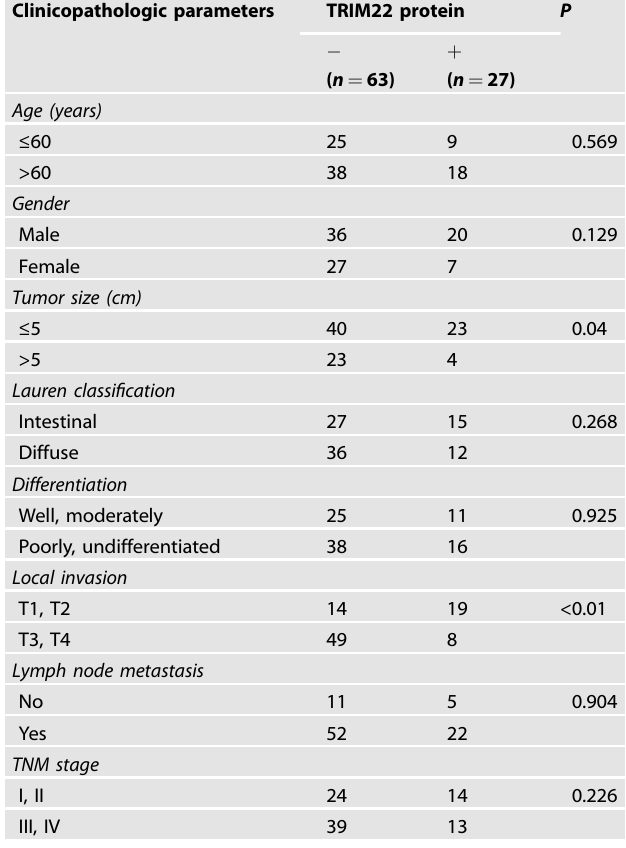
Table 1. Relationship between TRIM22 expression level and clinicopathologic variables in 90 gastric cancer tissues. Clinicopathologic parameters TRIM22